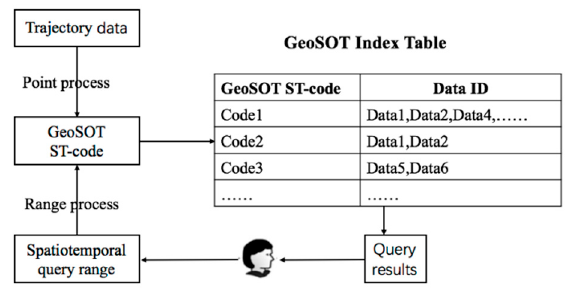
Figure 5. The retrieve model based on the GeoSOT ST-index.